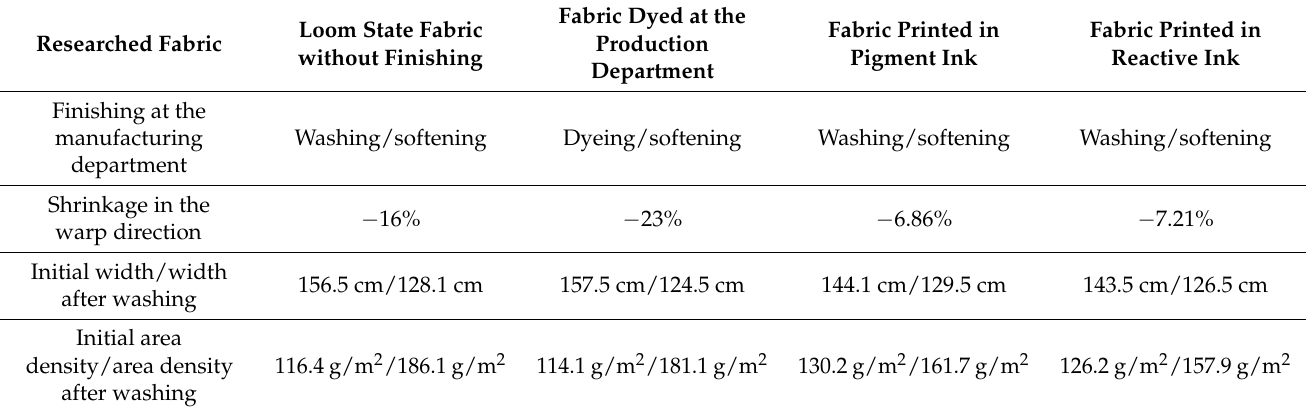
Table 4. Analysis of results of the researched linen/silk fabric after washing, softening, and